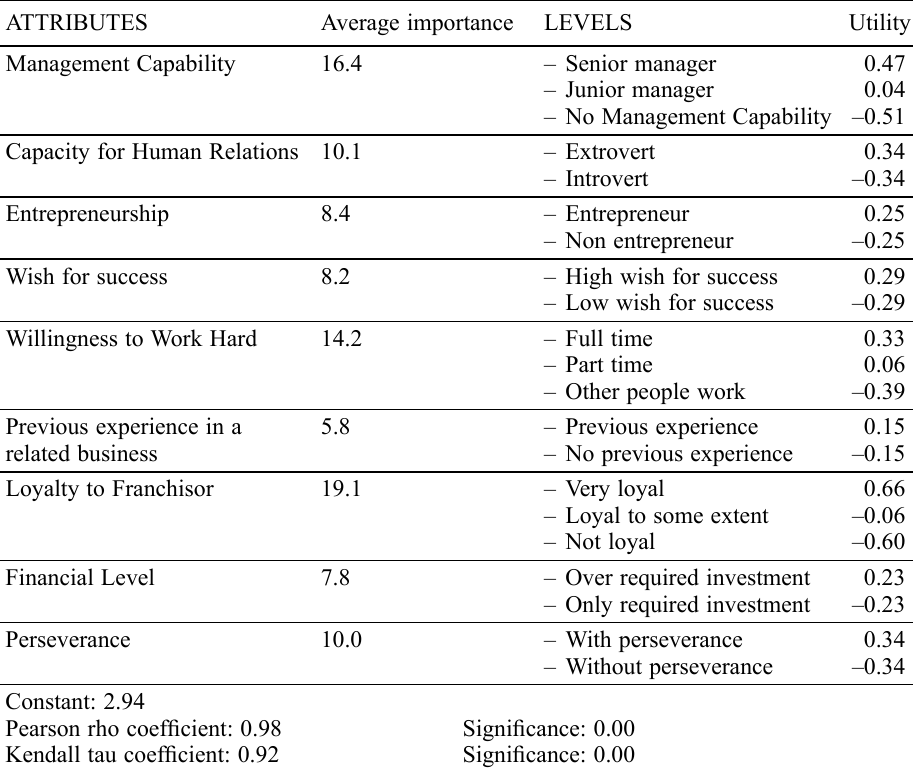
Table 4. Relative importance of attributes and partial utility of the